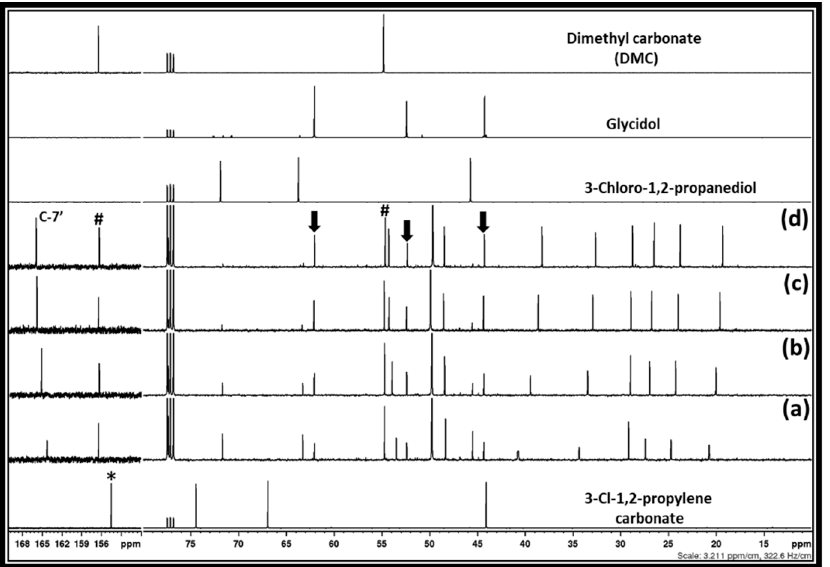
Figure 5. 13 C NMR spectra for the room temperature and DBU catalyzed transesterification of 3-chloro-1,2-propylenecarbonate in methanol, ( a ) 30 min, ( b ) 2 h, and ( c ) 6 h and, ( d ) 18 h (Downward arrows and # sign showed carbon atoms belongs to the glycidol and DMC, respectively).